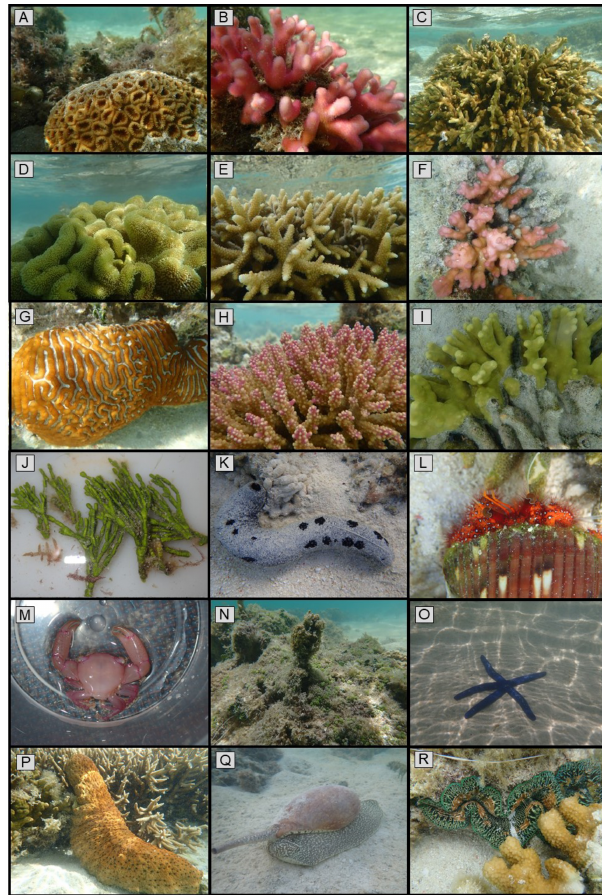
Figure 2. Cross section of coral, algal, and invertebrate diversity observed within the study area. (a) Dipsastraea sp.; (b) Stylophora pistillata ; (c) Montipora digitata ; (d) Sarcophyton sp.; (e) Acropora sp.; (f) Pocillopora sp.; (g) Platygyra sp.; (h) Acropora secale ; (i) Porites attenuata ; (j) Halimeda sp.; (k) Holothuria atra ; (l) Dard- anus megistos ; (m) Trapezia serenei ; (n) assemblage of Caulerpa sp. and Laurencia sp. algae covered in scum sp.; (o) Linckia lae- vigata ; (p) Stichopus herrmanni ; (q) Melo amphora ; (r) Tridacna maxima